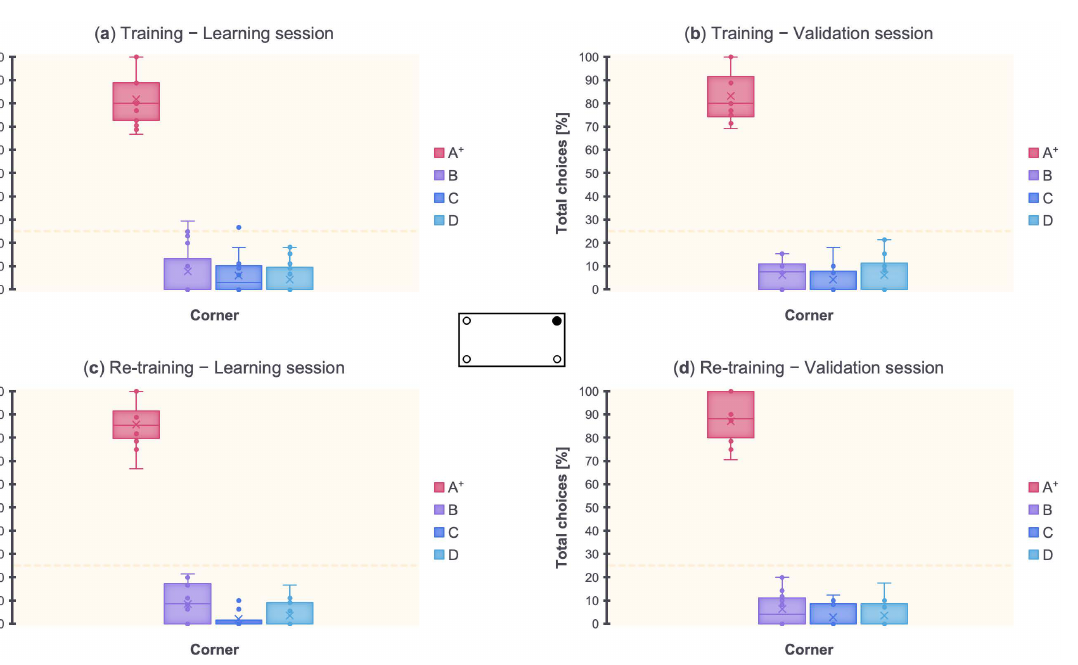
Figure 3. Results. Total choices [%] toward the arena’s four corners (A + , B, C, D). ( a ) Training phase, learning session. ( b ) Training phase, validation session. ( c ) Re-training phase, learning session. ( d ) Re-training phase, validation session. The dotted line indicates the chance level